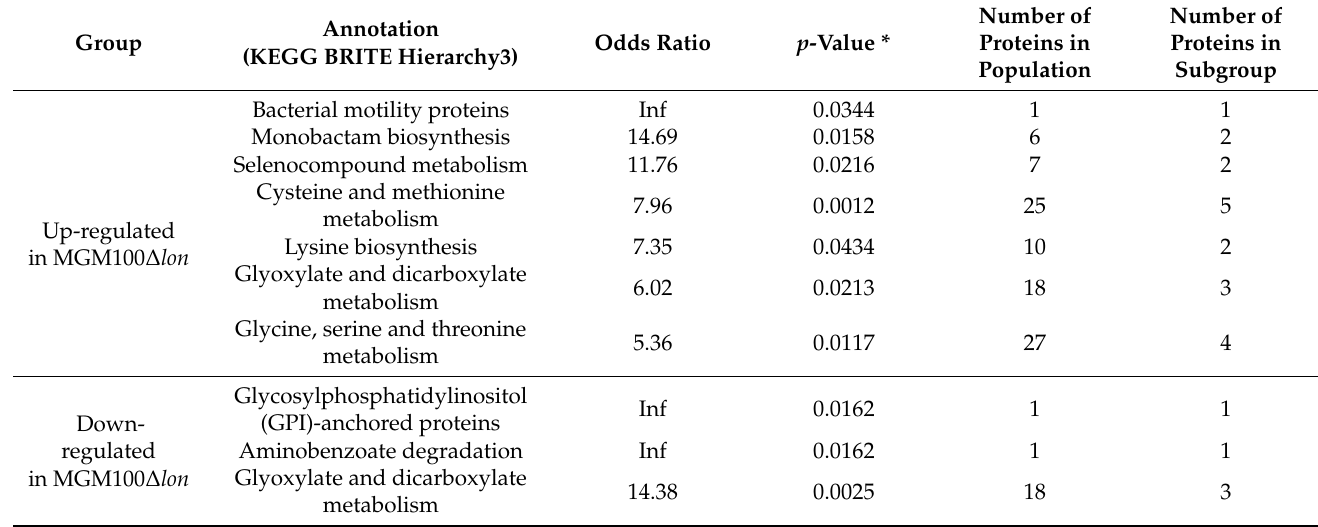
Table 4. Enrichment analysis for the proteins with specific changes by the deletion of Lon